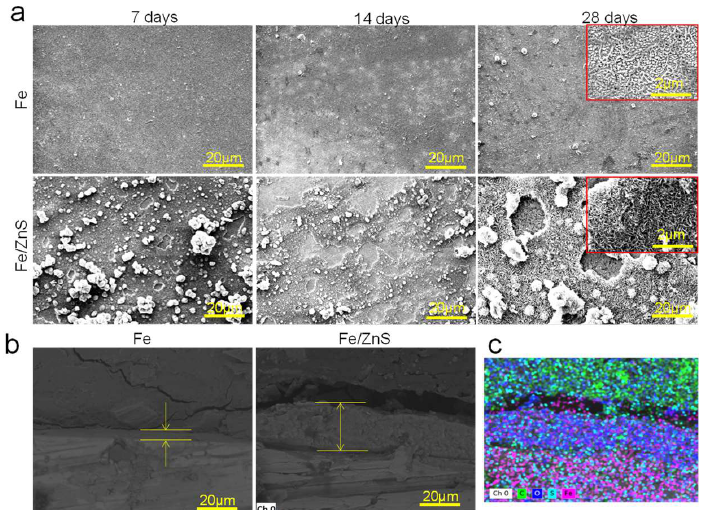
Figure 2. ( a ) SEM showing the typical corrosion surface of Fe and Fe/ZnS composite after immersion in SBF; ( b ) the cross section of corrosion production film and ( c ) the corresponding EDS mapping.